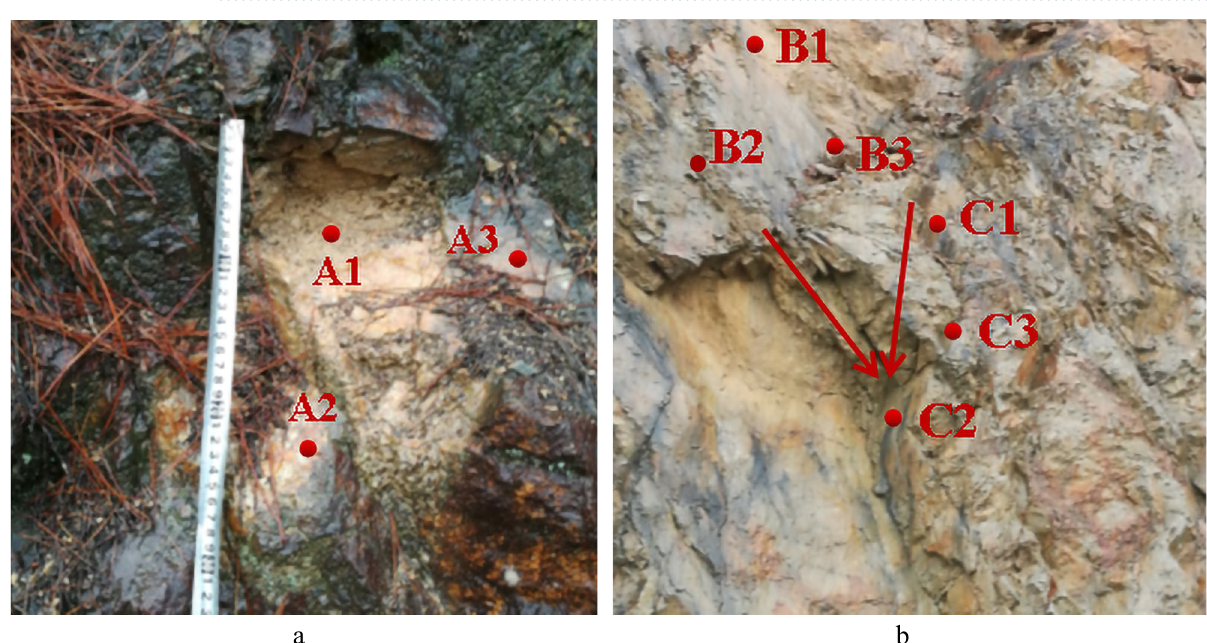
Figure 9. The diagram of the relationship between the scanning line and the trace.